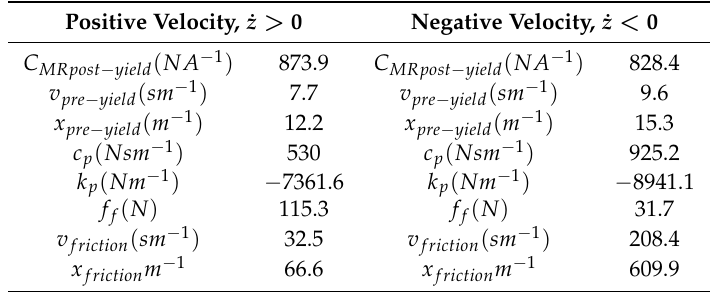
Table 1. Semi-Phenomenological (SP) asymmetric model parameters.